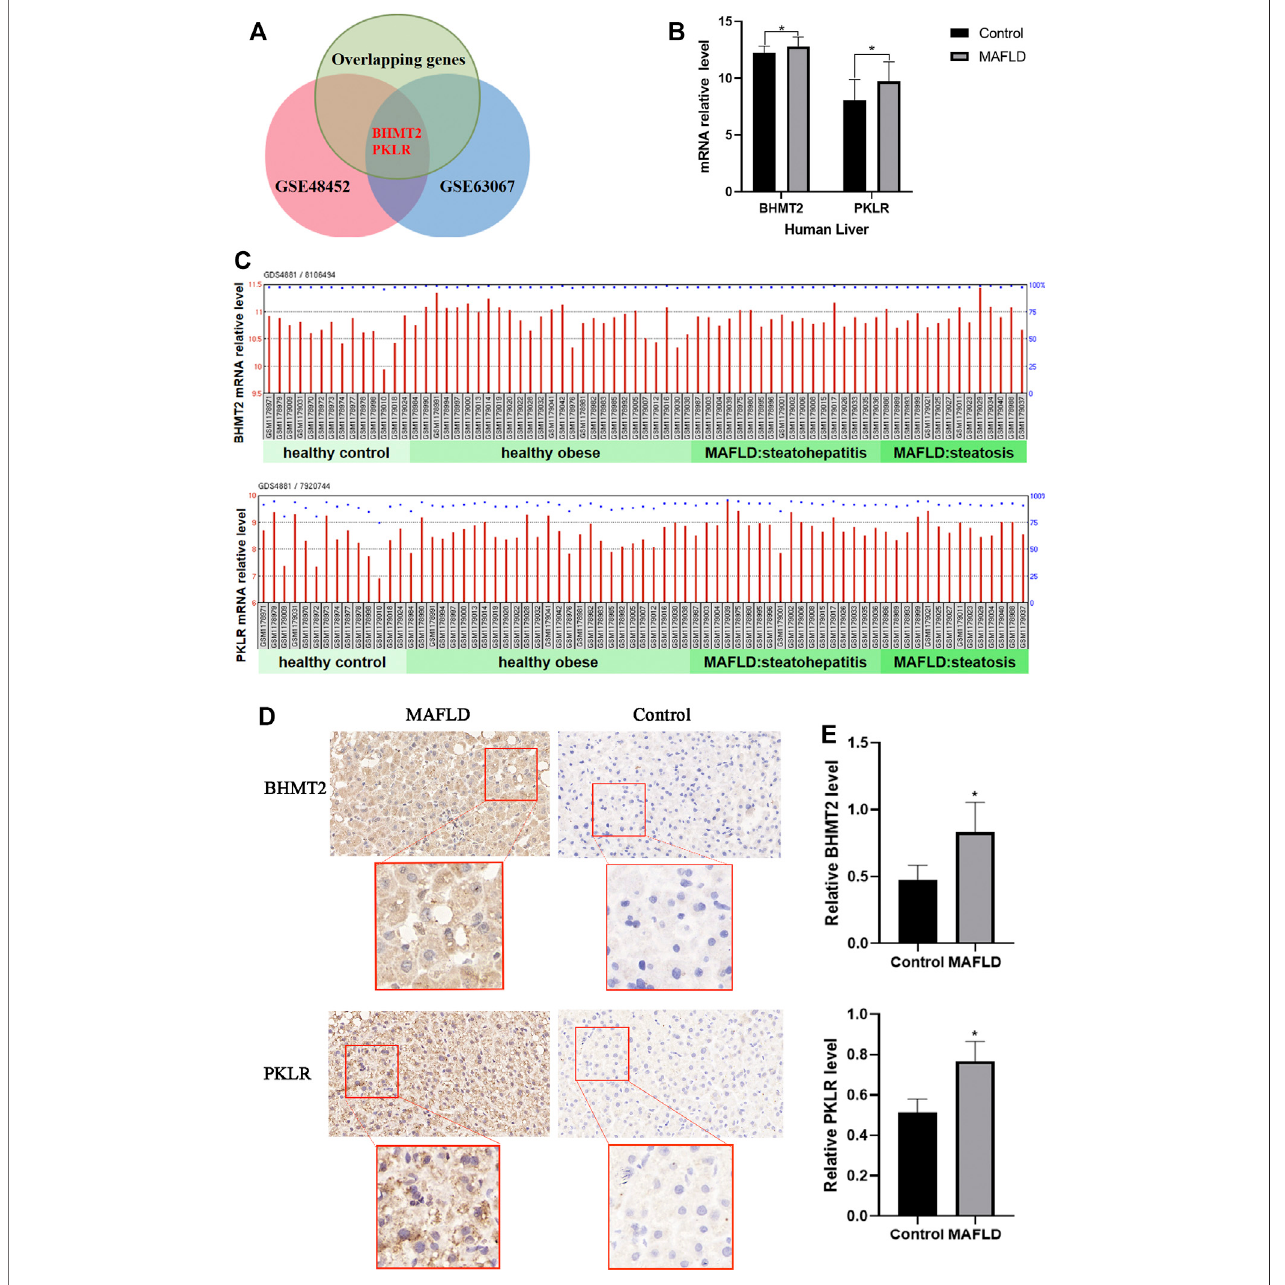
FIGURE 5 | Expression of BHMT2 and PKLR was elevated in patients with MAFLD (A) Venn diagram of genes appearing in the three groups of differentially expresses genes. (B) mRNArelativelevels ofBHMT2and PKLR detected inthe liverof MAFLD patients and controls inthe GSE48452 dataset. (C) mRNA relative levels ofBHMT2and PKLR detected inthe liverofMAFLDpatientsand controls. (D) Immunohistochemistry assayofBHMT2and PKLR inlivertissues ofpatients with MAFLD and controls. (E) Statistical results of the relative expression of BHMT2 and. PKLR. The relative level of BHMT2 and. PKLR were determined by calculating the average intensity of each sample normalized to the average intensity of the control sample. (* p < 0.05; ** p < 0.01; *** p < 0.001).